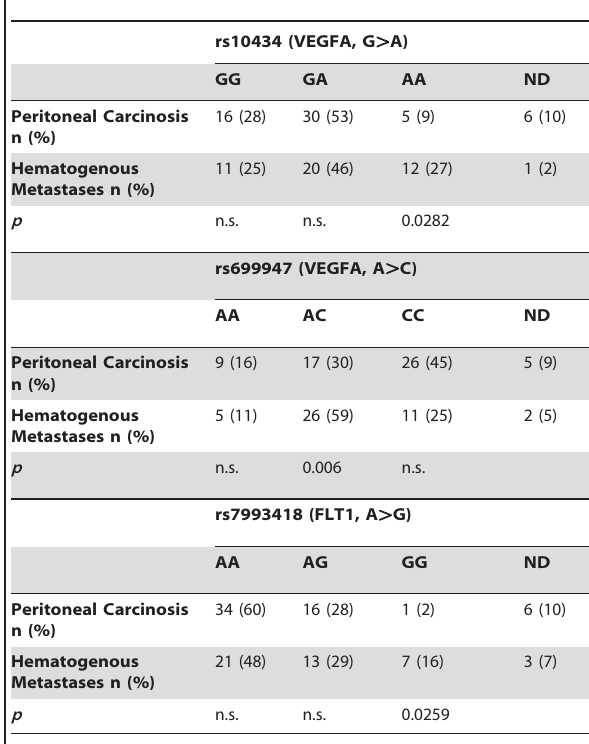
Table 3. Detailed results for tumour VEGF and VEGF-R polymorphisms associated with either peritoneal-only diffusion or hematogenous metastases at univariate analysis.